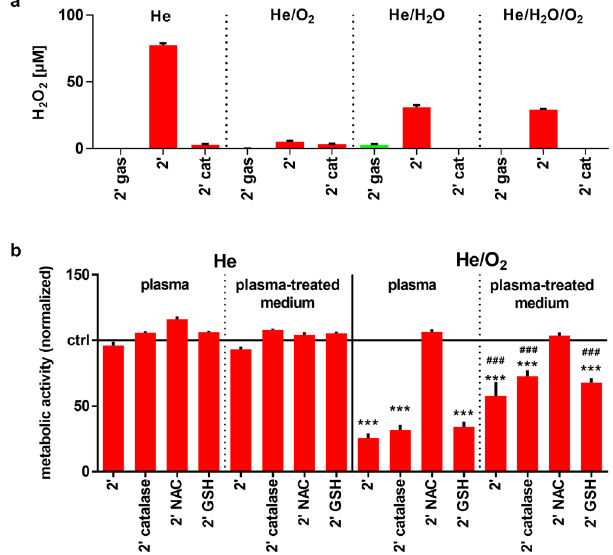
Figure 4. Not H 2 O 2 but another long-lived oxidant was responsible for THP-1 cell killing. ( a ) H 2 O 2 was assessed in plasma-treated cell culture medium using different feed gas conditions, and He plasma showed the highest production with catalase scavenging H 2 O 2 in any feed gas condition. ( b ) THP-1 cells were either exposed to He or He/O 2 plasma or to He or He/O 2 plasma-treated medium which was immediately added afterwards using different feed gas conditions and in presence or without of either catalase, NAC, or GSH. Cells were assayed for metabolic activity 24 h later, and showed a significant reduction ( *** ) in presence of catalase or GSH but not NAC. This effect was less pronounced and differed significantly (###) for plasma-treated medium compared to direct treatment in the He/O 2 condition. Data are presented as mean + S.D. of two experiments. Statistical differences ( *** / ### p < 0.001) were determined using 1-way ANOVA within each gas condition and plasma treatment regimen, and t-test to compare individual values for a single treatment regimen within each gas